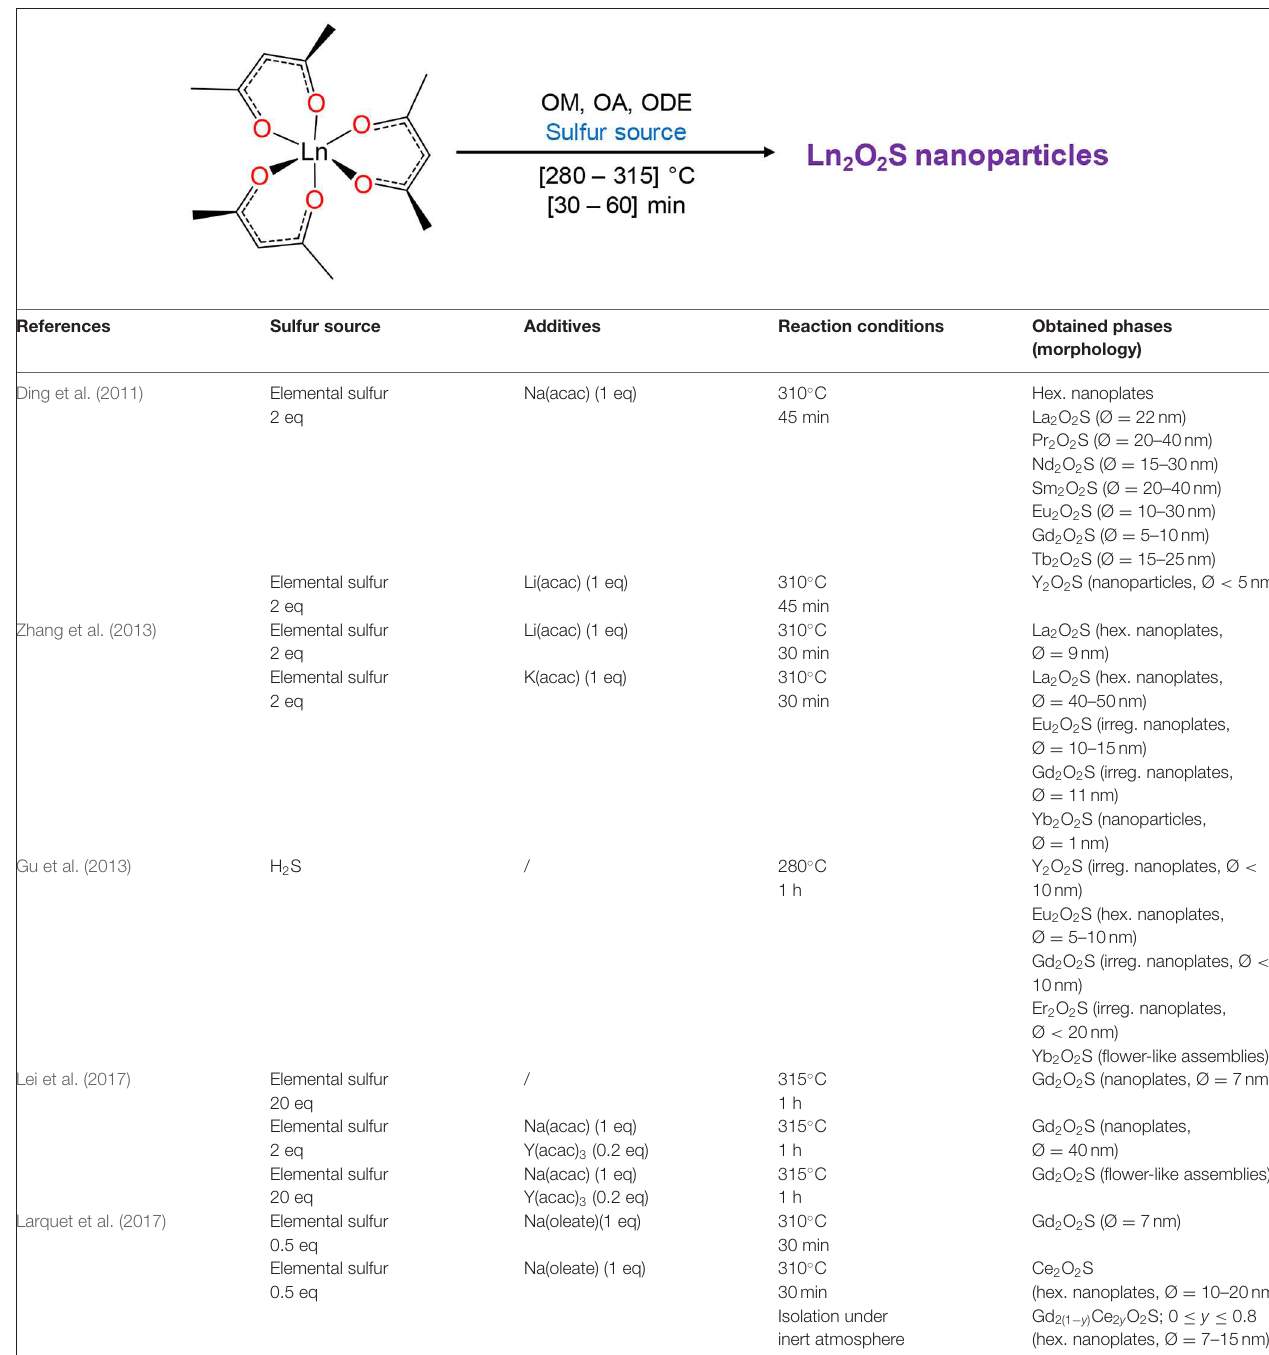
FIGURE 15 | Ding’s alkali-based synthesis of lanthanide oxysulfide and its derivatives. The number of equivalent (“eq” in the table) is the molar ratio between the reactant and metal. The term “hex.” stands for “hexagonal” and “irreg.” for “irregular.”